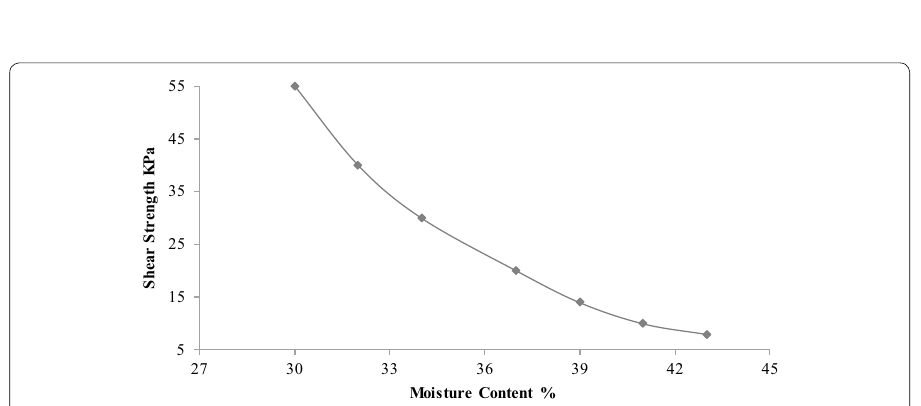
Fig. 2 Variation in shear strength with moisture